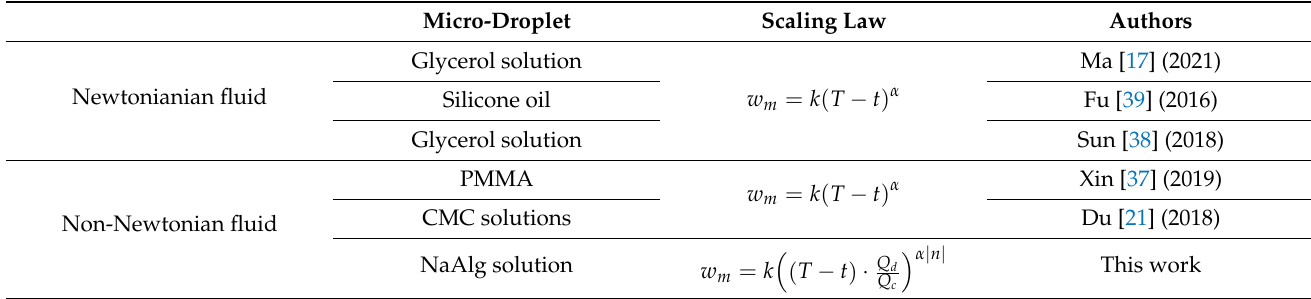
Table 2. The normalization model of minimum neck width w m in the squeezing stage. Micro-Droplet